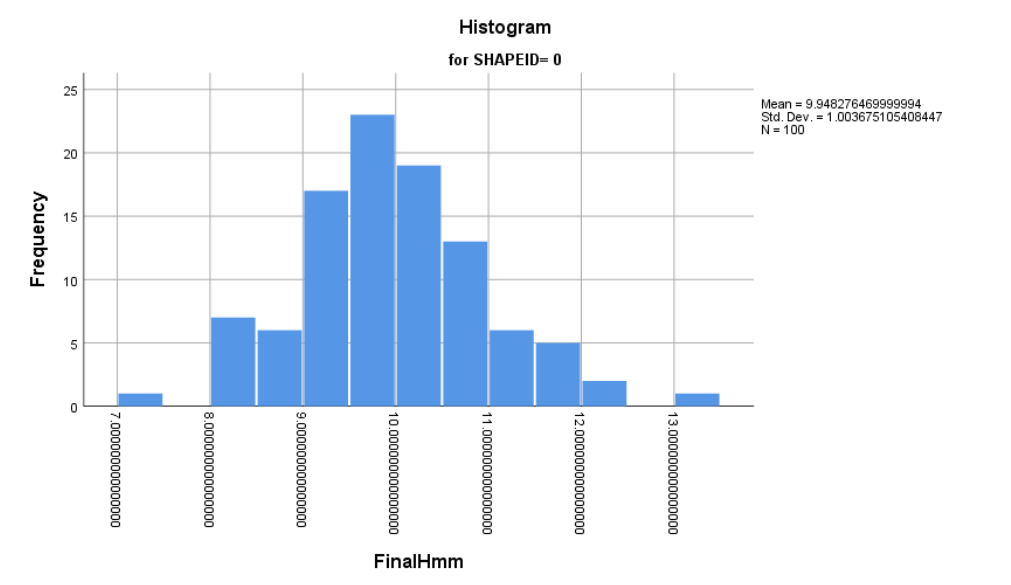
Figure A2. Grow height adjustment for 10